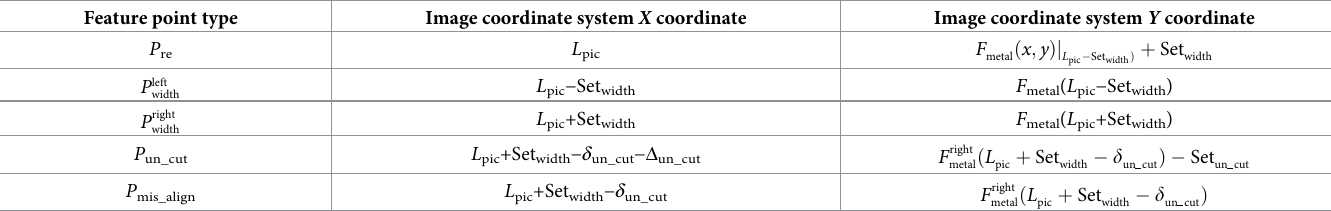
Table 2. Location of the feature point in the simulation of the undercut weld profile curve with the defect parameter. Feature point type